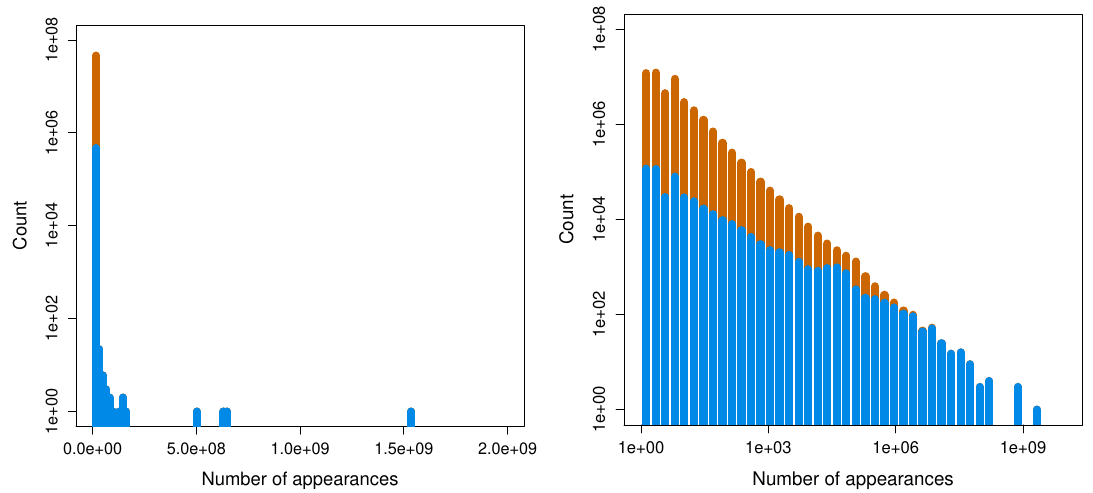
Figure 3 . Histograms of the frequencies of facet appearances, with bins spaced linearly (left panel) , and logarithmically (right panel) . The orange bars represent the total number of facets, while the blue bars show the amount for which the number of FRTs is explicitly computed, and thus